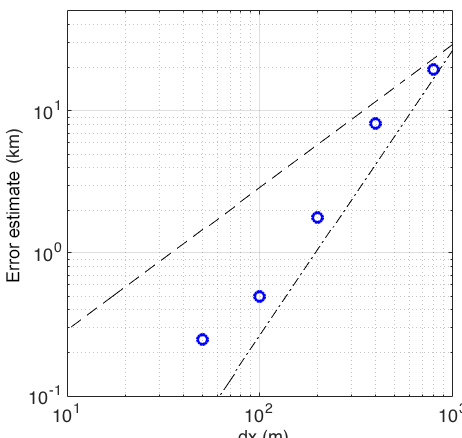
Figure 5. Convergence of the Stnd experiment as a function of along-flow grid resolution (circles), as discussed in Sect. 5.2. Error estimates for grounding-line position are based on Richardson error estimation. Black dashed and dash-dot lines show perfect linear and quadratic convergence rates (respectively).